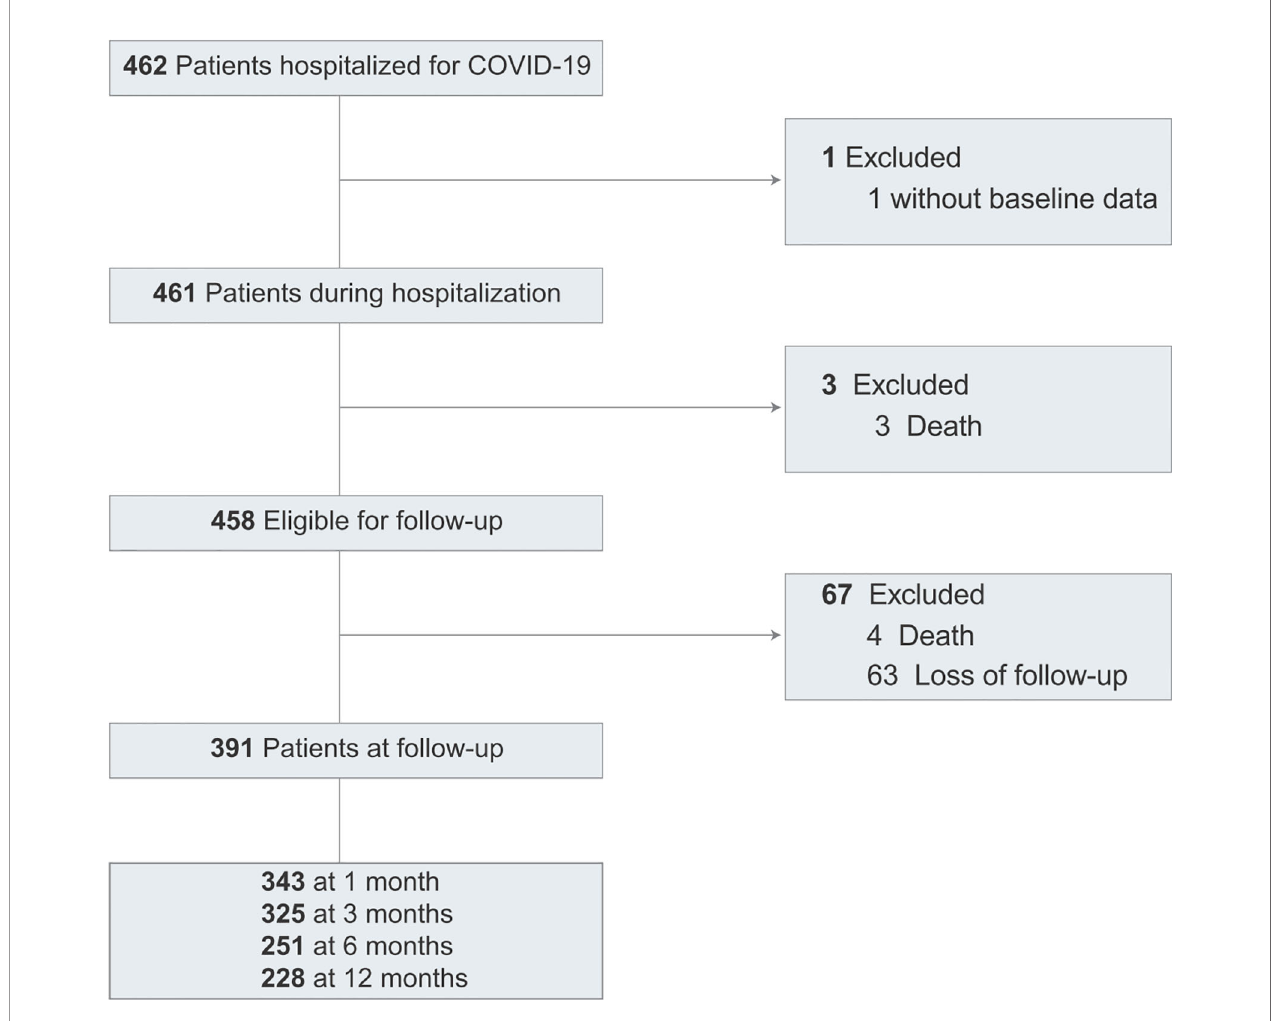
FIGURE 1 | Study fl ow